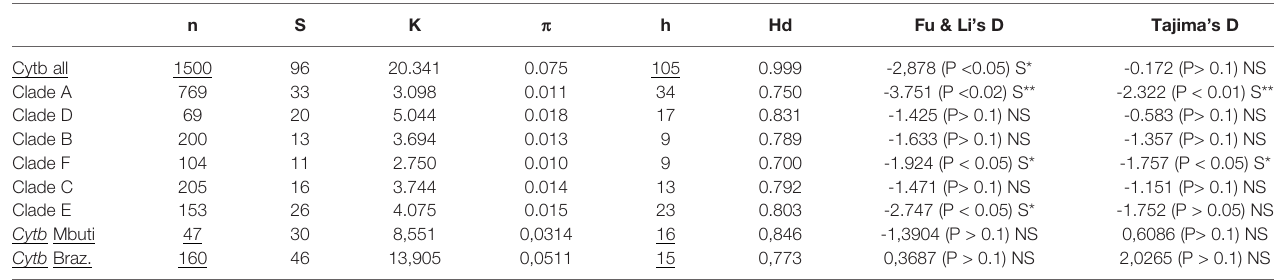
TABLE 3 | Analysis of genetic diversity indices and neutrality tests (Fu & Li ’ s D and Tajima ’ s D) on mitochondrial cytb sequences.